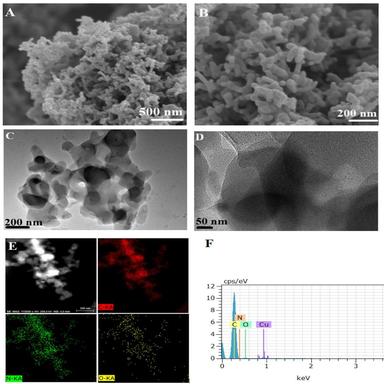
SEM of N-CCs at low (A) and high (B) magnification, TEM of N-CCs at low (C) and high (D) magnification, Element mapping (E) and energy dispersity X-ray spectrum (F) of N-CCs.